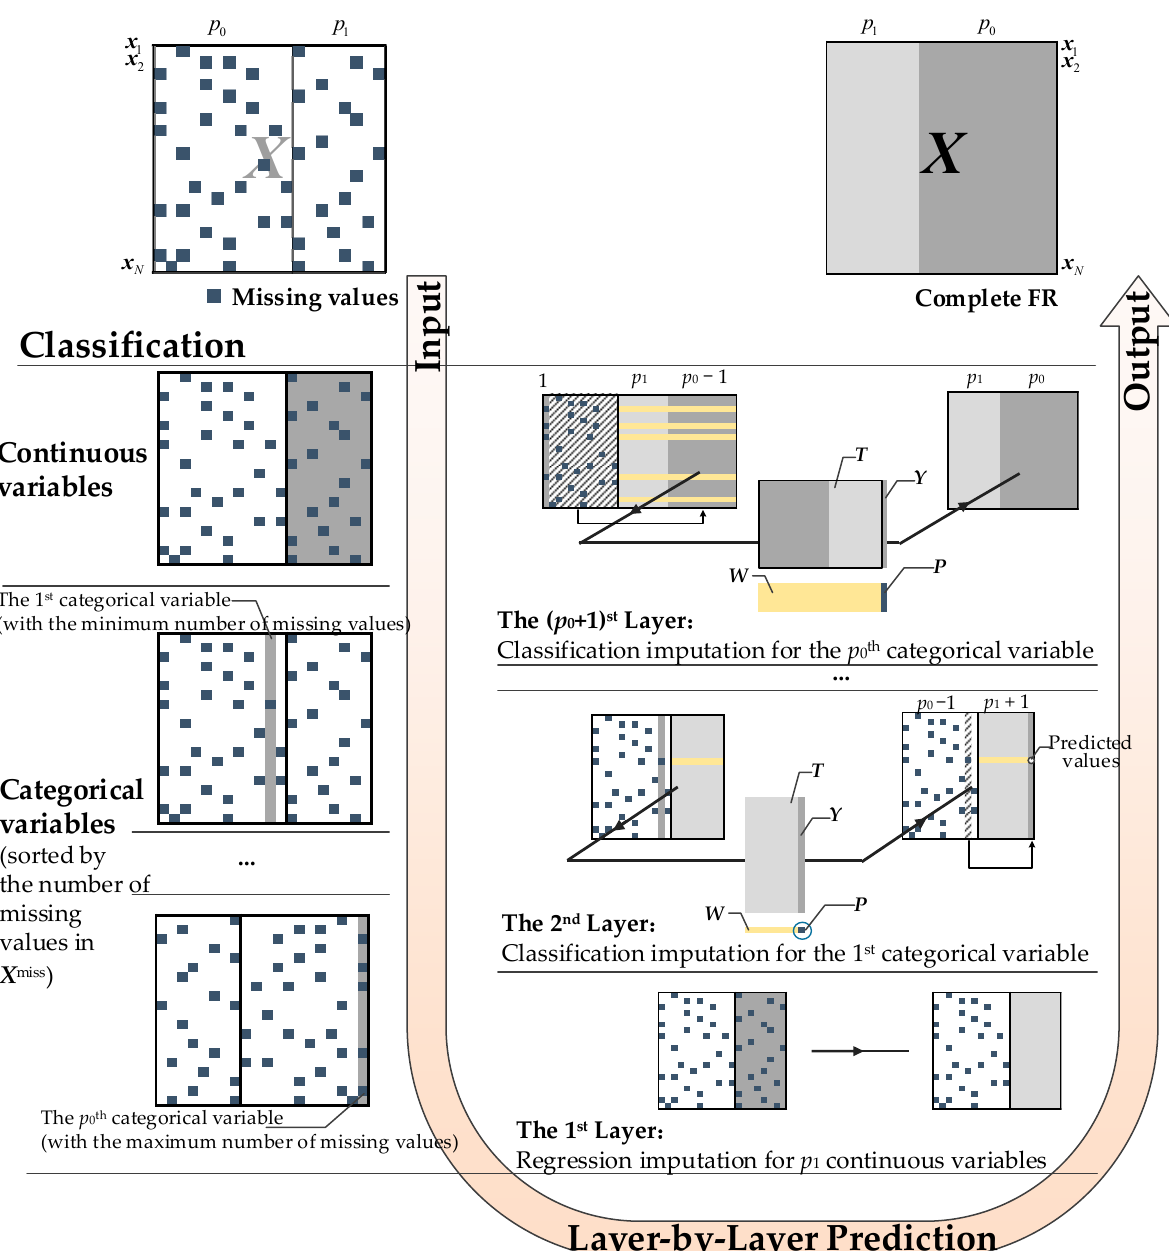
Figure 3. Multi-layer framework for missing values prediction.